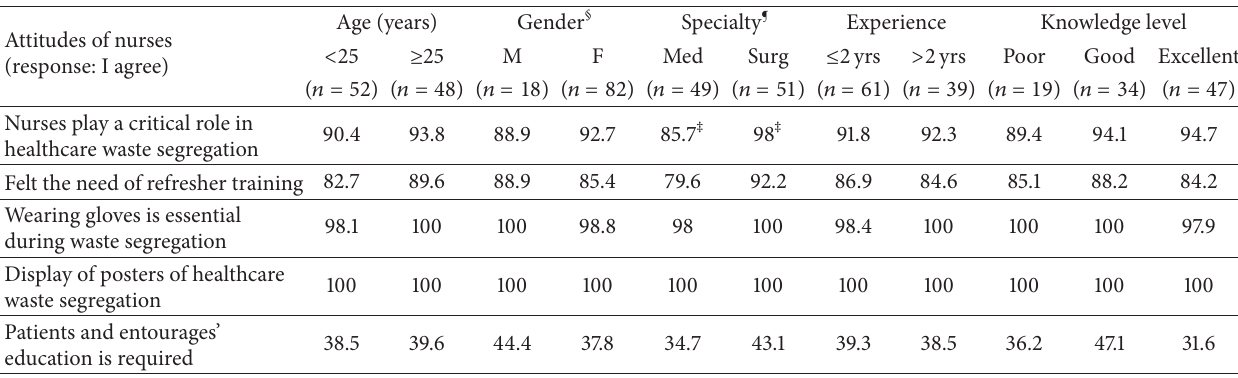
Table3:Attitudesofthenursestowardshealthcarewastemanagementaccordingtotheirage,gender,departmentofwork,nursingexperience, and knowledge level †